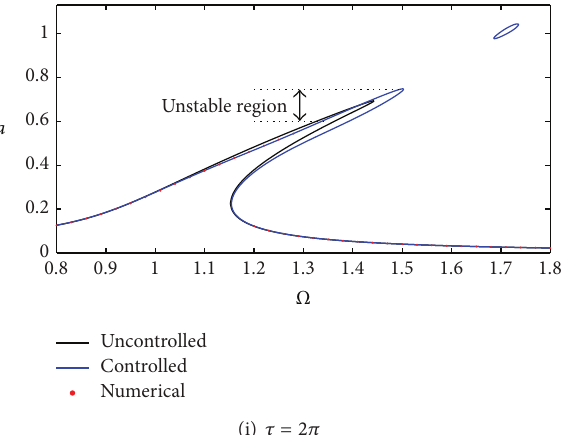
Figure 4: Amplitude-frequency relationships of the primary resonance for the controlled system with different time delay 𝜏 ( 𝜁 1 = 0.025 , = 0.05 , 𝑓 = 0.05 , 𝑘 = 1 , and ̂𝜆 = 0.4 ). 𝜁 3 1